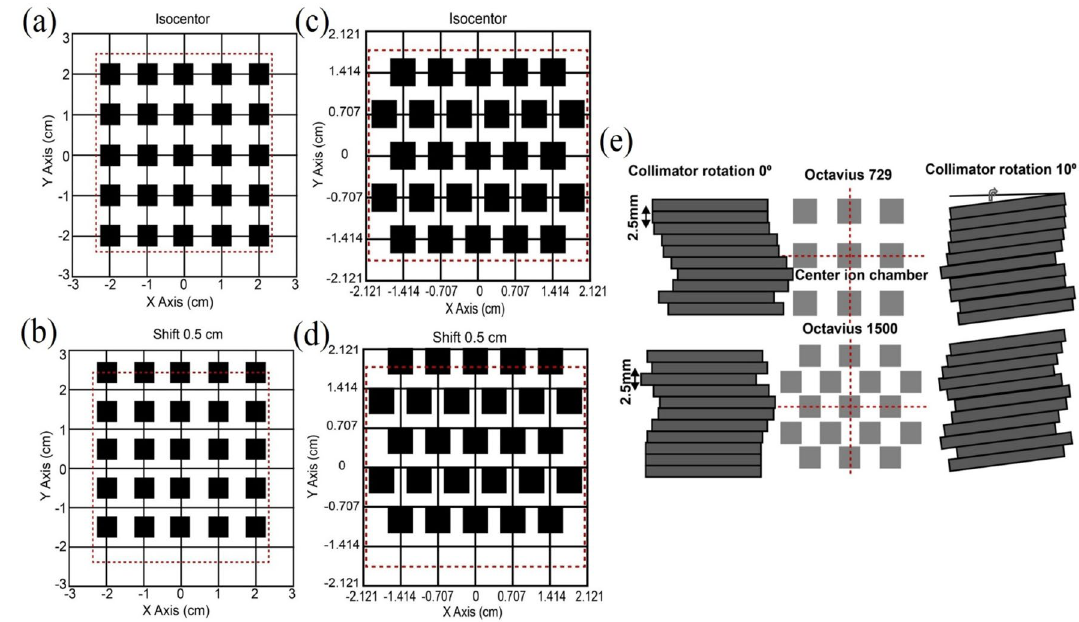
Figure 1. Schematic diagrams of sampling sequence for detectors 729 and 1500. (a,c) Were obtained by positioning detectors in the isocenter, i.e., standard acquisition. (b,d) Were obtained by longitudinal moving treatment couch + 0.5 cm. The square shape represents one single ion chamber. (e) Sampling schematic of ion chambers on inner 32 leaf pairs at multi-leaf collimator angle 0° (as typically set in IMRT) and 10° (as typically set in arc delivery). The dashed line indicates the central axis of beam across the center area with a row of detectors lateral and longitudinal, respectively. The position of the central ion chamber coincides with the isocenter. At collimator angle 0°, the lateral dashed line is aligned with the gap between a central pair of 729. Then, readings of the ion chamber rows are associated with the leaf pairs, whereas abutting pair align with the gap between two rows of detectors and completely misses. When the measurement was acquired by longi- tudinally moving the linac couch + 5 mm, the completely missed leafs were sampled. All leafs were completely sampled after both measurements had subsequently coalesced. In an individual detector, leafs are oriented along with the gantry motion, and the entire penumbra and tail of two leaf tips are exposed to the dose regardless of whether they are moving. When the collimator rotates at 10°, a portion of each leaf is sampled during each measurement, but the total number of acquired leafs is the same as those of 0°, so it is possible for either the side or the tip of leafs to partially sweep a detector due to leaf movements that are not parallel with gantry motion. For detector 1500, a checkerboard pattern of arrangement and single ion chamber size allows sampling on most leafs at any collimator angle, and either side or tip of leafs completely sweep detectors by coalescence. The outer 28 leaf pairs are similar to above.